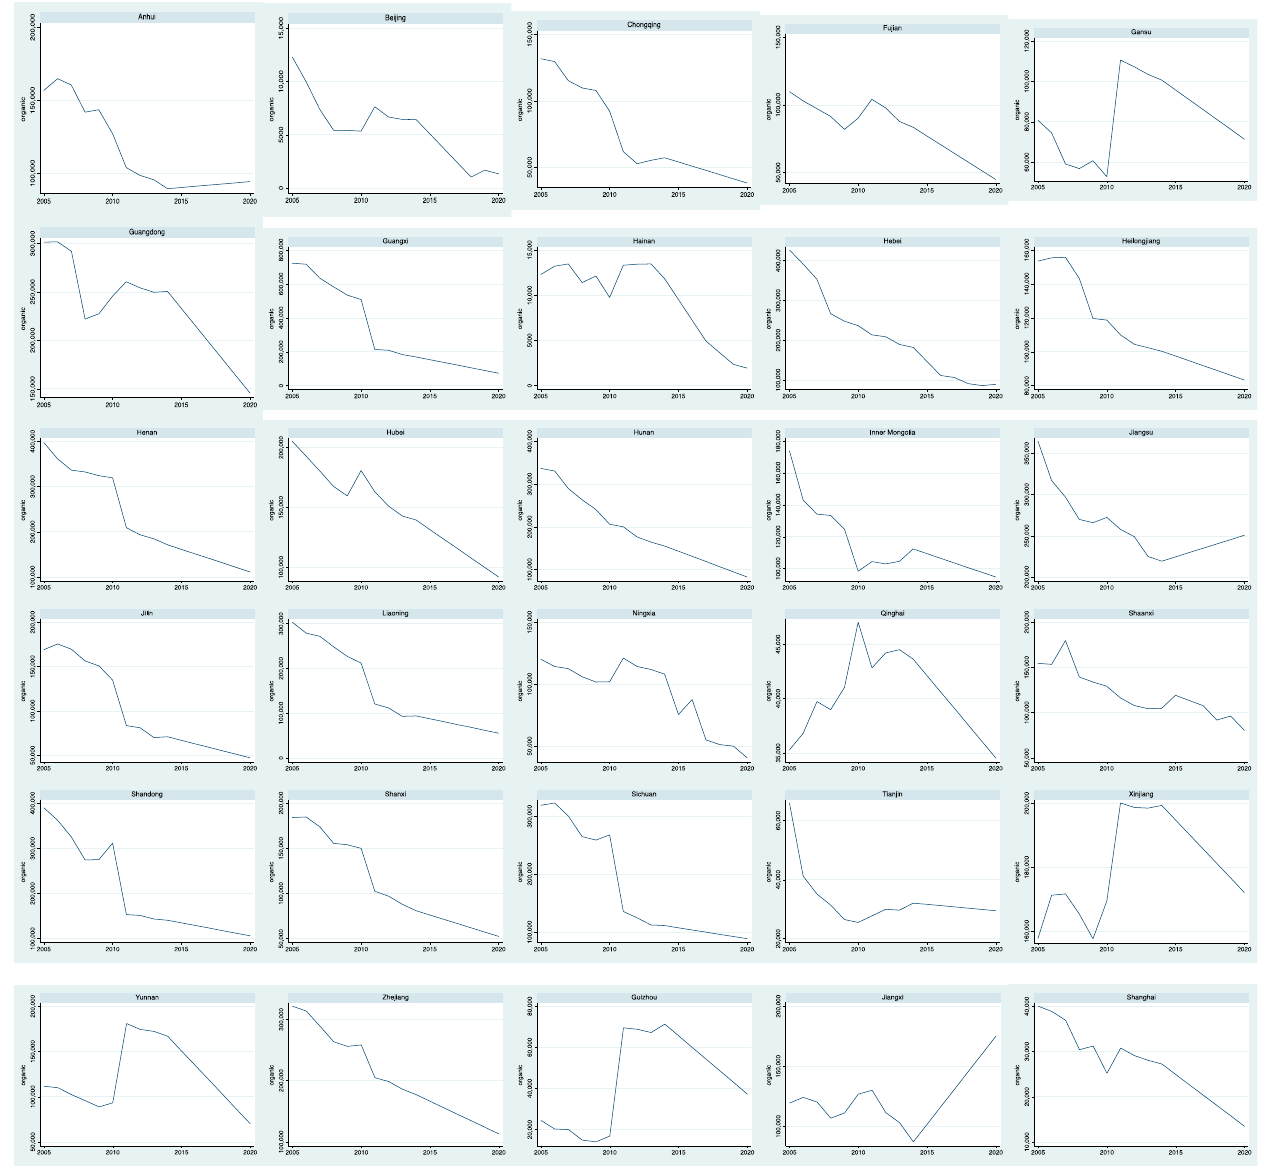
Figure 2. The emissions of organic pollutants.